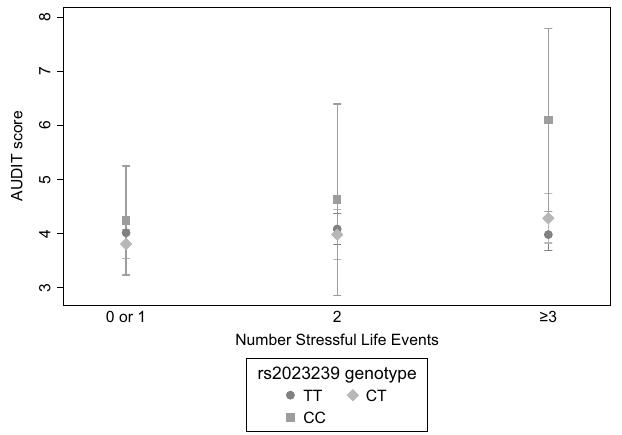
Figure 1. Testing for interaction between rs2023239’s C-allele and number of adult stressful life events (SLEs) on predicted AUDIT scores in PART I. Mean predicted continuous AUDIT score by rs2023239 genotype (TT, CT, CC) and three-level categorical adult SLEs (0/1, 2 or ≥ 3), adjusted for age, sex, child SLEs (≥ 1) and a diagnosis of anxiety or depression. Results from the two-way ANOVA suggested a tendency toward effect heterogeneity for SLE exposure, with risk-allele carriers experiencing a sharper increase in AUDIT scores across SLE categories, although the interaction term did not reach statistical significance (adjusted p = 0.23). Error bars represent 95% confidence